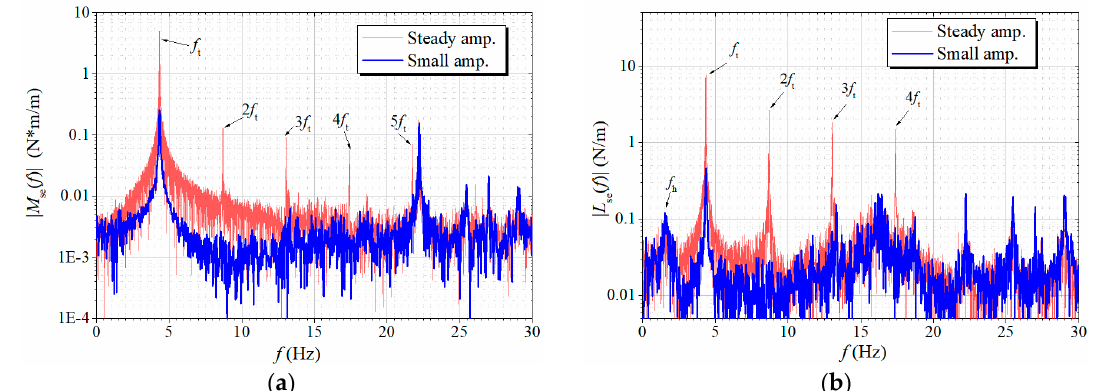
Figure 21. Amplitude spectra of the measured aerodynamic ( a ) torsional moment and ( b ) aerodynamic lift during a post-critical LCO (Case B1, U * = 6.623).